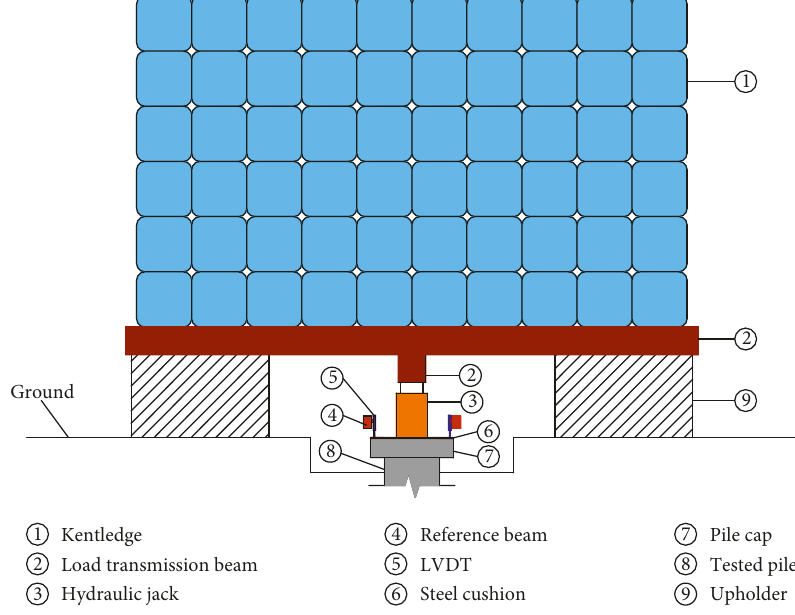
Figure 6: Schematic of the loading test reaction